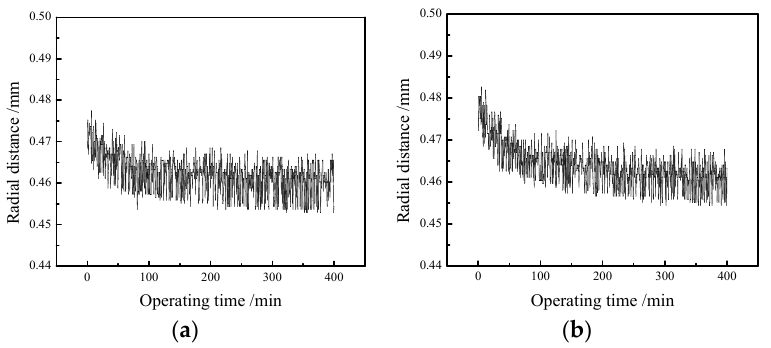
Figure 11. The variation of oil ‐ film thickness from displacement transducer H1 with time at 150 rpm ‐ 6 MPa. ( a ) S220; ( b ) M220.